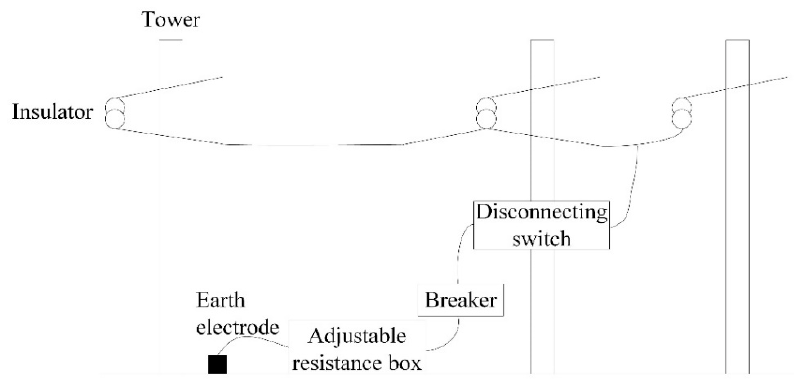
Figure 10. The wiring diagram at the grounding point.